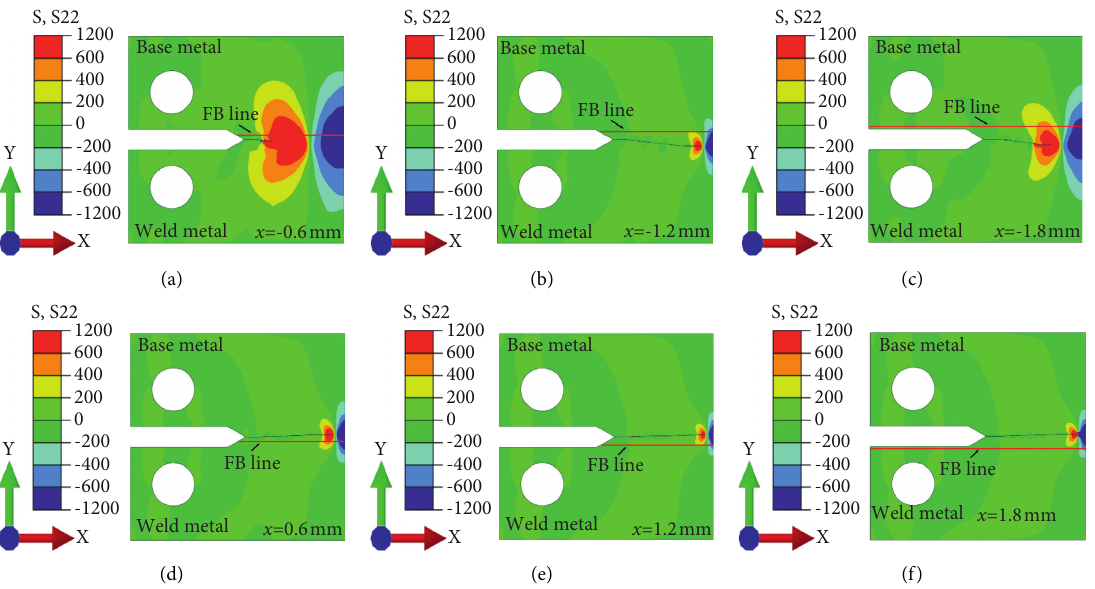
Figure 16: Crack extension paths and tensile stress distribution of longitudinal cracks: (a) x � − 0.6, (b) x � − 1.2, (c) x � − 1.8, (d) x � 0.6, (e) x � 1.2, and (f) x �